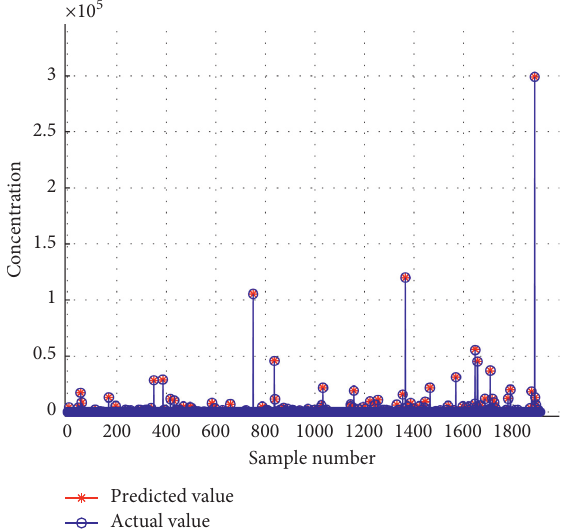
Figure 8: The fitting effect diagram of Binzhou training set data.